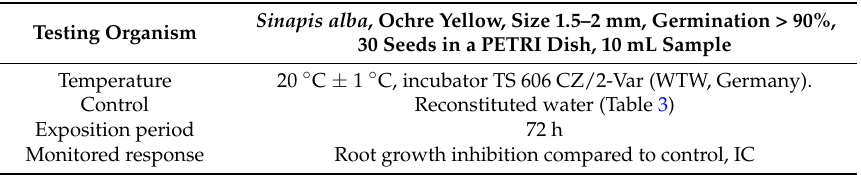
Table 2. Test conditions of Sinapis alba growth